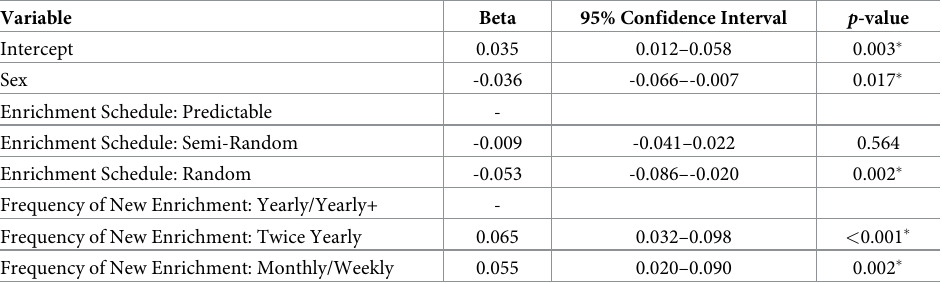
Table 8. Results from multivariate model examining group active ( � p < 0.05).